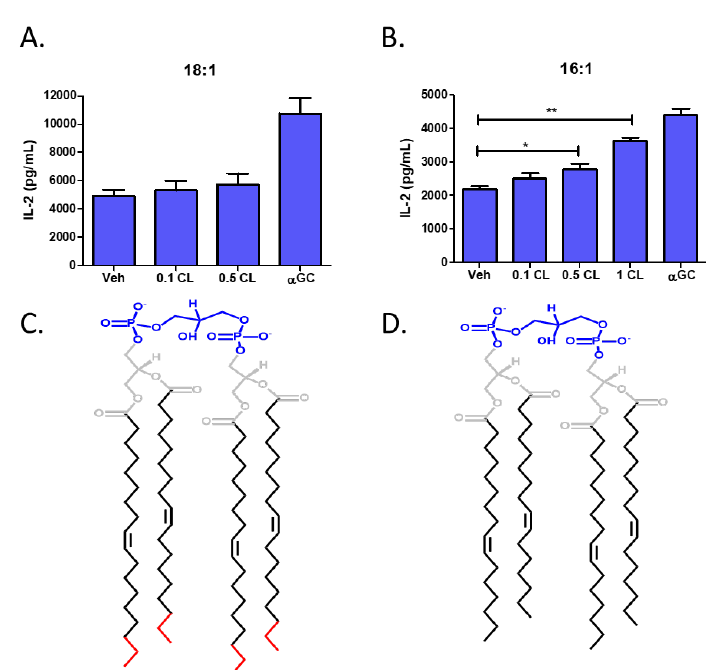
Figure 7. Identification of cardiolipin species that activates type 1 NKT cells. L-CD1d cells were pulsed in the presence of either purified ( A ) 18:1 or ( B ) 16:1 cardiolipin for 4 h at 37 °C prior to co-culture with DN32.D3 for 24 h. IL-2 production was then measured by ELISA. Each ELISA was conducted in triplicate. Structures of 18:1 and 16:1 cardiolipin are shown in ( C ), ( D ) respectively with the head group in blue, the acyl chain in black, and the extra carbons in red. Data was analyzed using a student’s t -test. * p < 0.05; ** p < 0.005 .